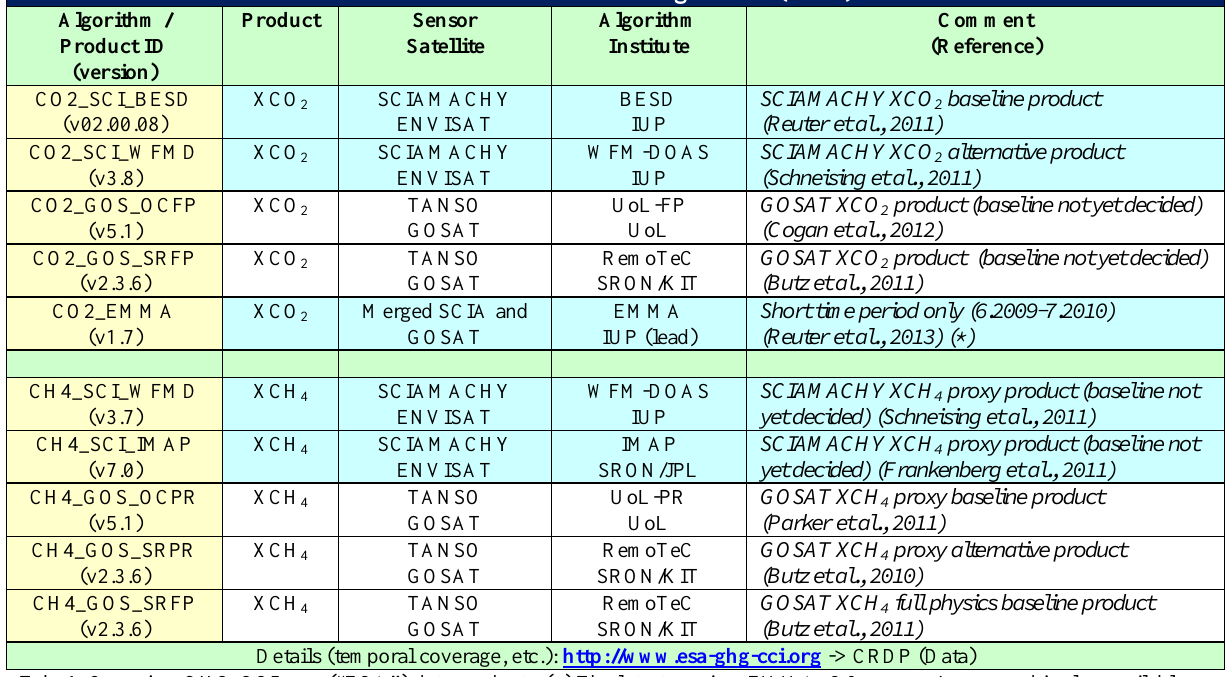
Tab. 1: Overview GHG-CCI core (“ECA”) data products. (*) The latest version, EMMAv2.0, covers 4 years and is also available on the GHG-CCI website.